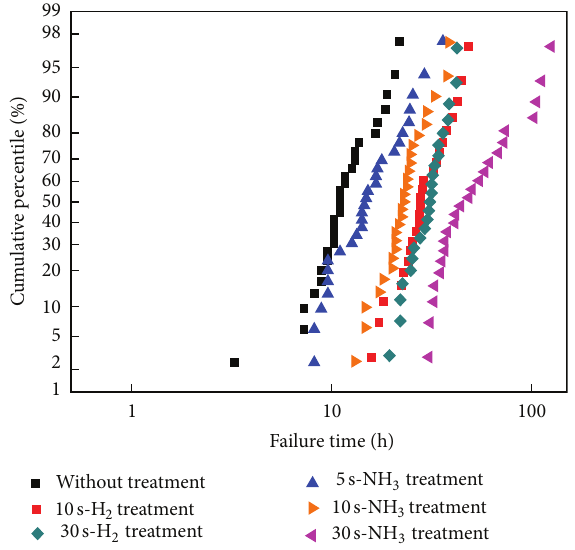
Figure 11: Cu EM failure time distribution for various plasma treatment